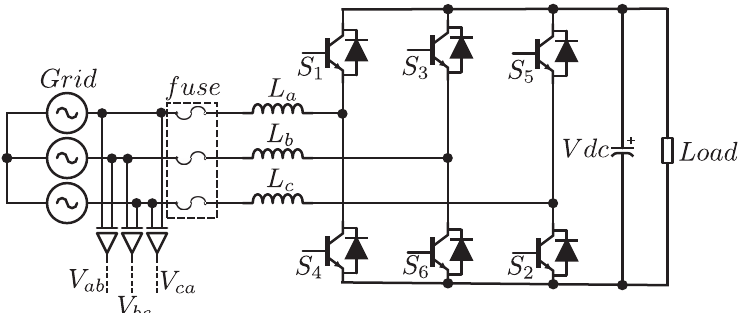
Figure 22. Three-phase AC/DC PWM PEC. Comparison of V ab , V bc , and V ca with a threshold is performed, and the value of the other sensors replaces a faulty sensor